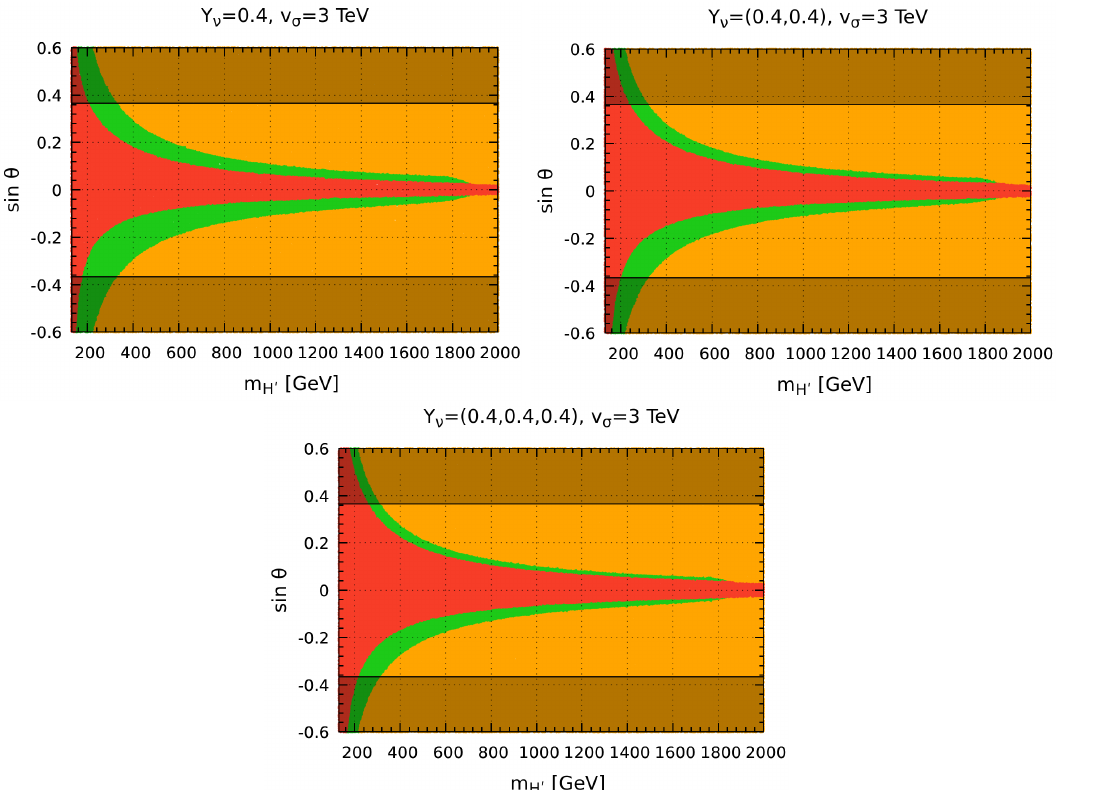
Figure 19 . Same as figure 18, but for v σ = 3 TeV. The region between the black lines is allowed by LEP-LHC